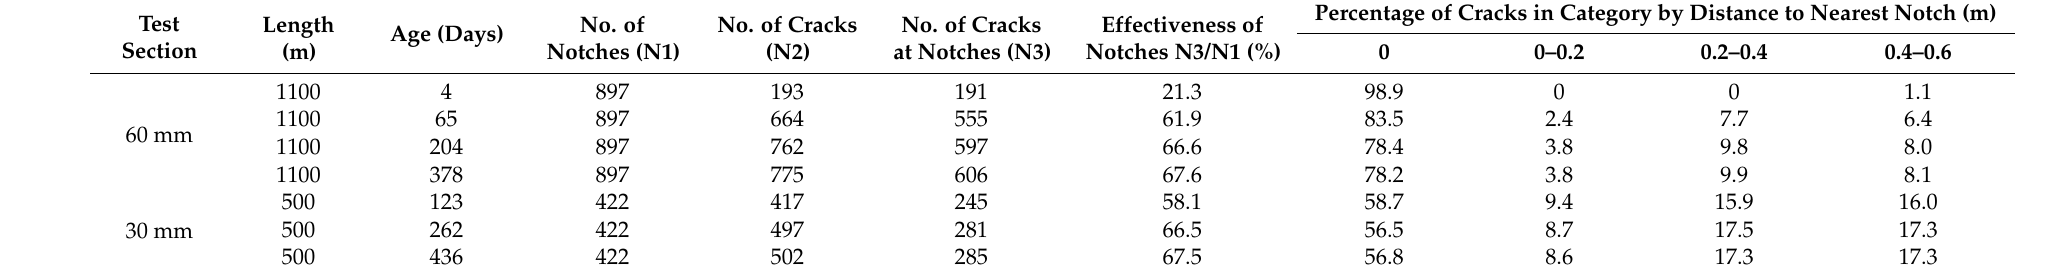
Table 2. Crack survey data on the 313 test sections